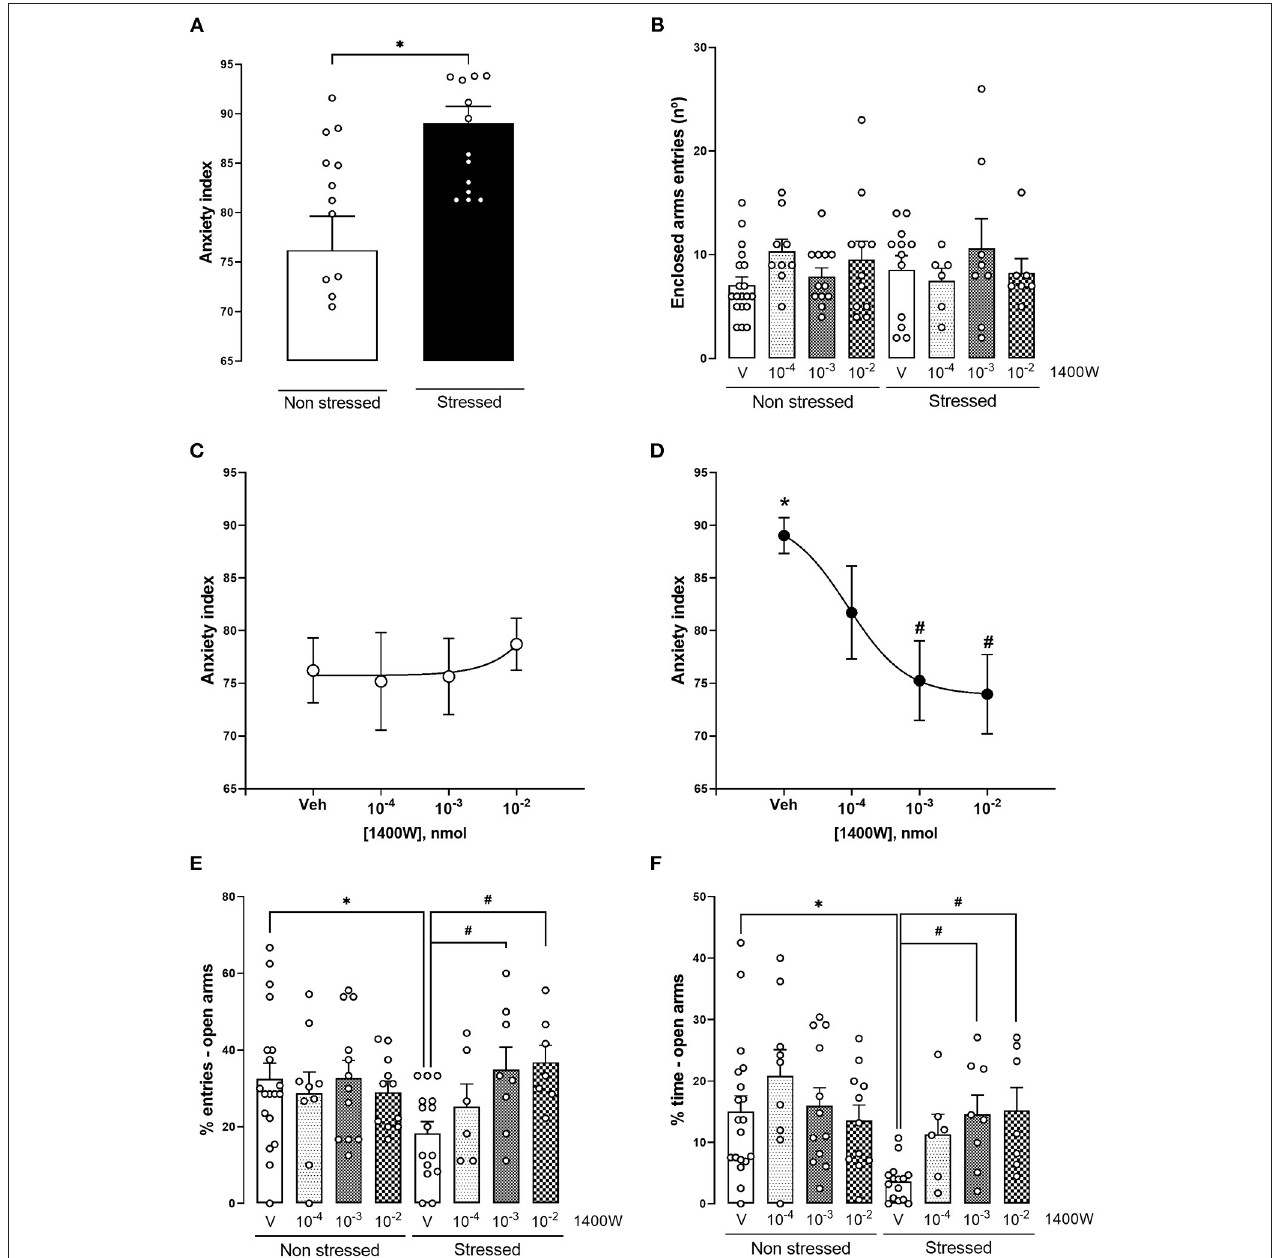
FIGURE 3 | iNOS inhibition reversed the anxiety behavior induced by acute restraint stress (RS) 24h later in the elevated plus-maze (A) . 1400W microinjections did not affect naïve animals’ behavior (C) . 1400W microinjections, at the doses of 10 − 3 and 10 − 2 nmol in stressed animals, prevented the anxiogenic-like behavior represented by a decrease in the anxiety index (D) and increase in the percentage of entries (E) and time (F) in the open arms of the maze. Also, stress and the treatments did not alter the number of entries in the closed arms (B) . Each point/bar represents the mean ± standard error of the mean (SEM). *Indicates p < 0.05 compared to the naïve vehicle group and # Indicates p < 0.5 compared to the stressed vehicle group (one-way analysis of variance (ANOVA) followed by Tukey’s post hoc test). n = 19, 9, 12, and 11 for naïve animals treated with vehicle, 1400W 10 − 4 , 1400W 10 − 3 , and 1400W 10 − 2 , respectively, and 15, 6, 8, and 7 for